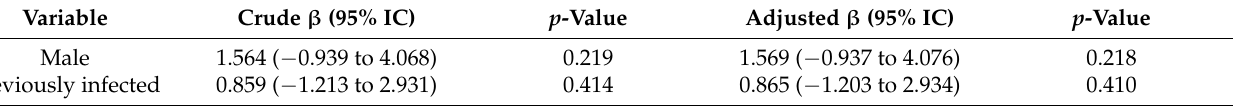
Ab Neutralization SARS-CoV-2 cPass™ after Booster